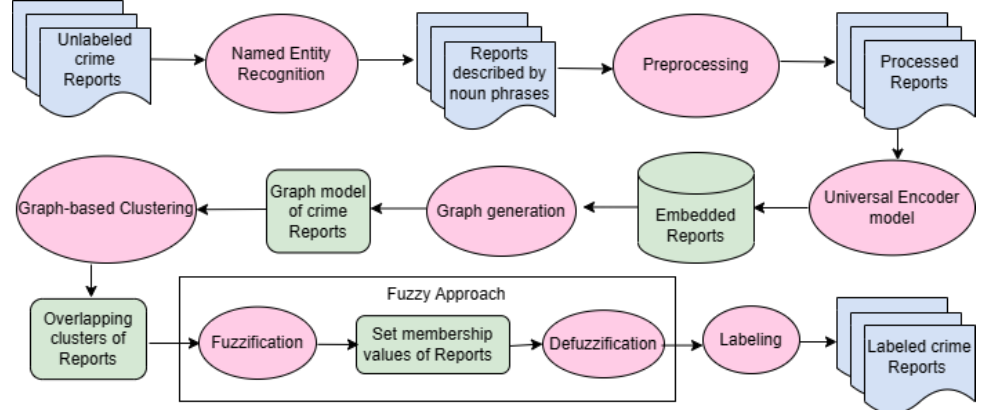
Figure 1. Workflow diagram of the proposed